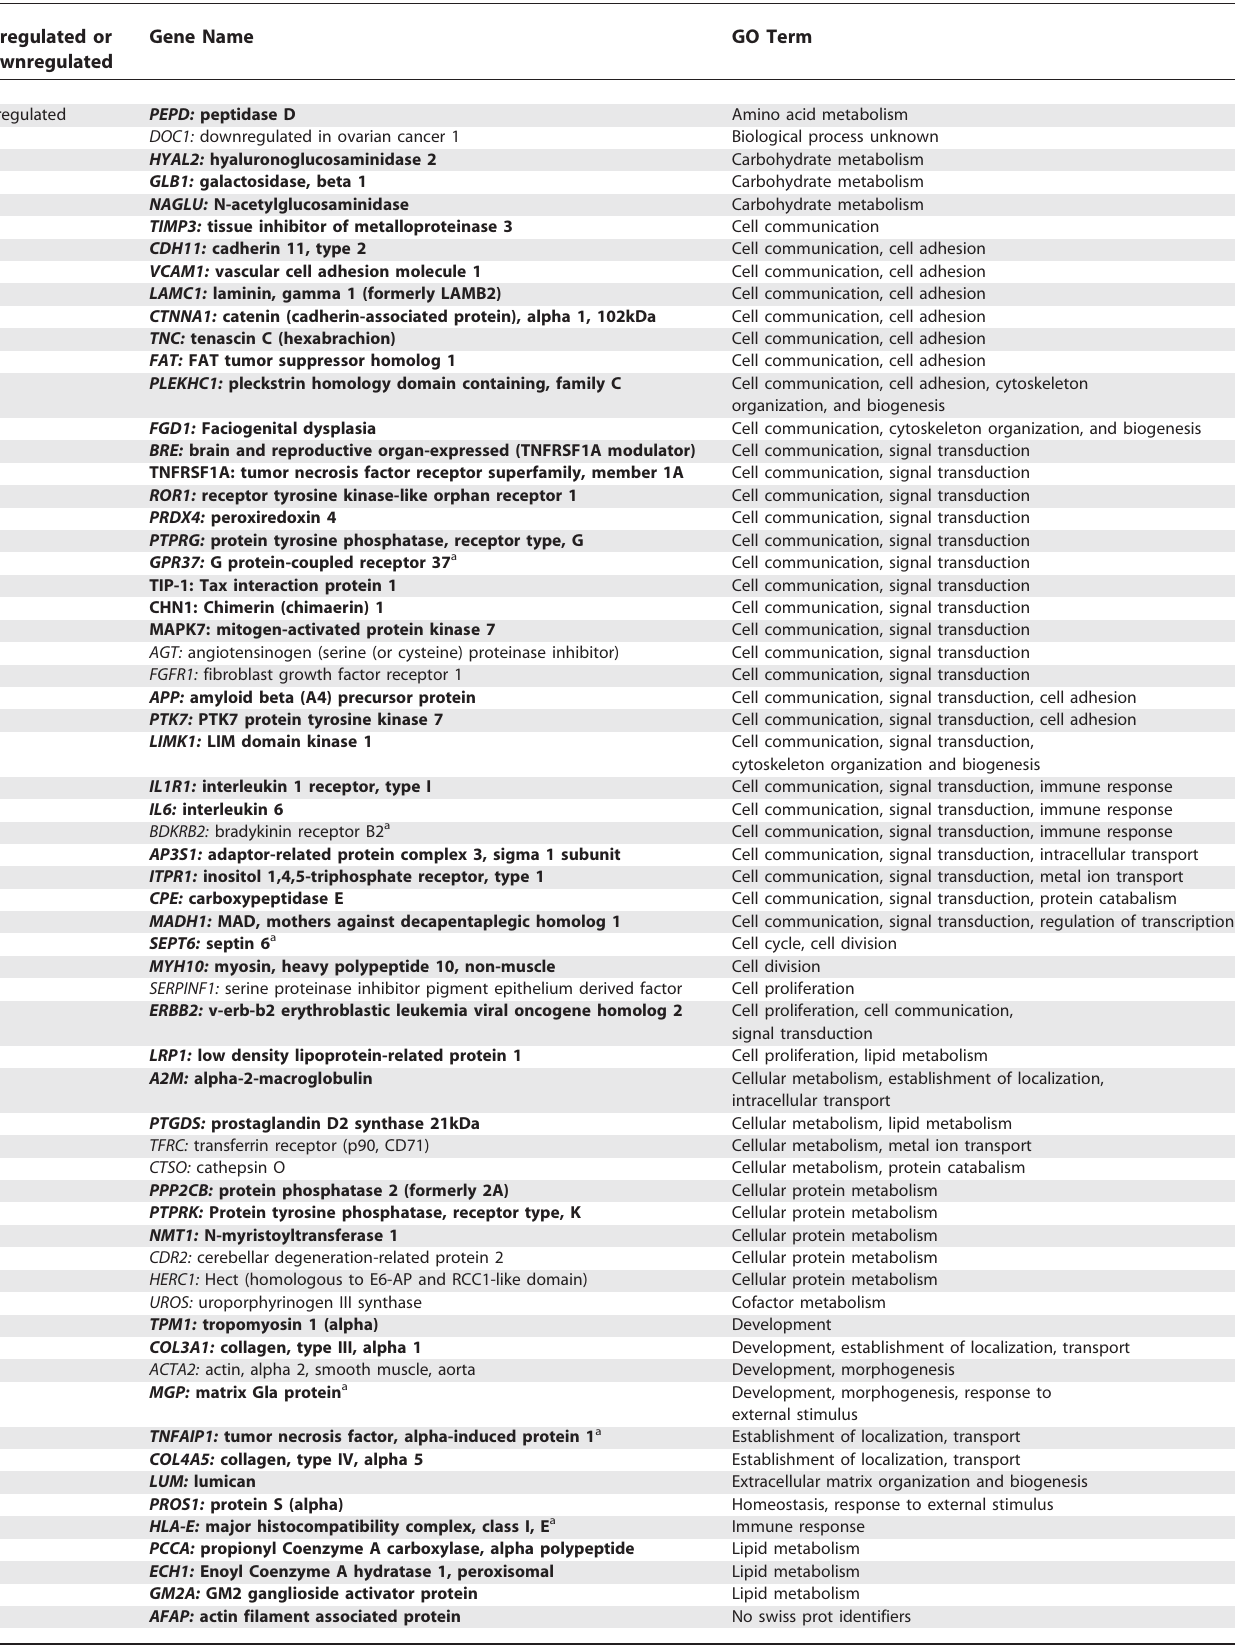
Table 2. Genes in the Quiescence Program Upregulated or